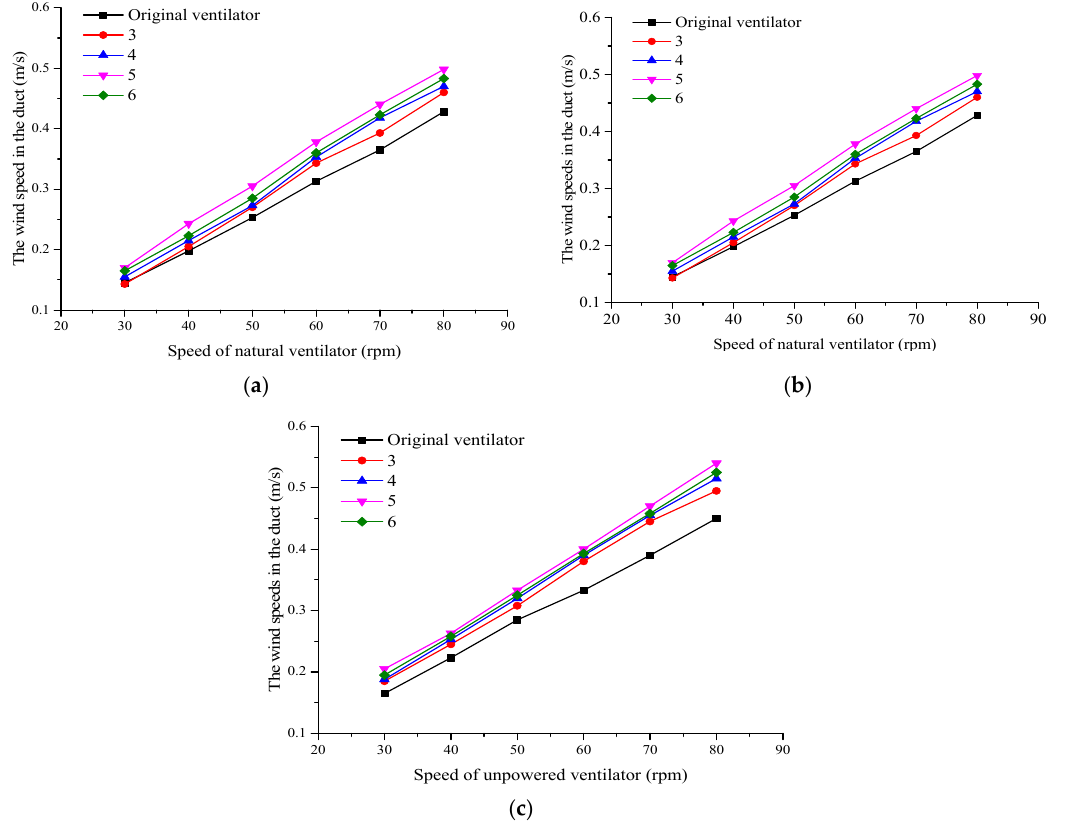
Figure 15. Relationships between wind speed in air duct and natural ventilator speed with different blade numbers at different testing points. ( a ) Testing point 3; ( b ) Testing point 4; ( c ) Testing point 5.